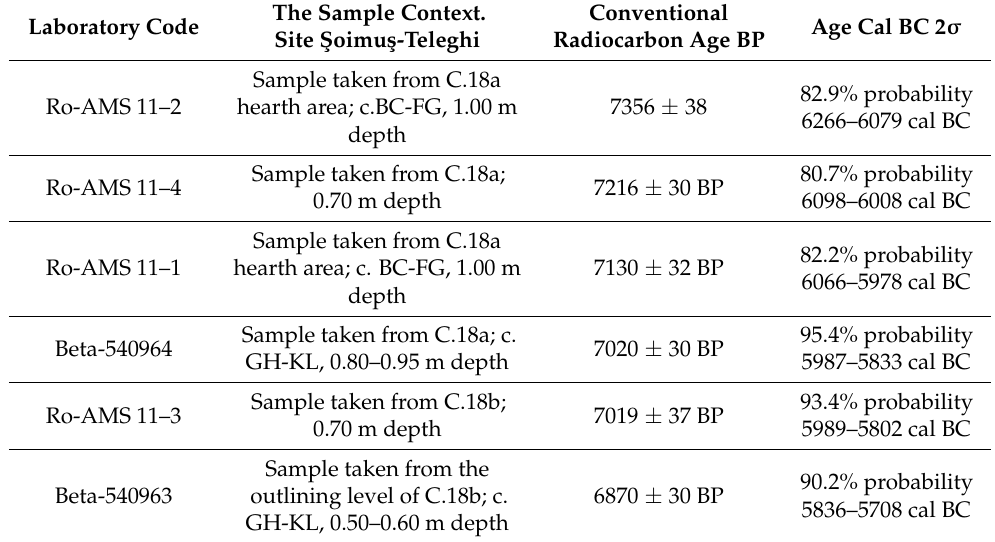
Table 2. List of AMS 14C dates from Șoimuș-Teleghi, features C.18a and C.18b. The 14C ages were calibrated using OxCal version